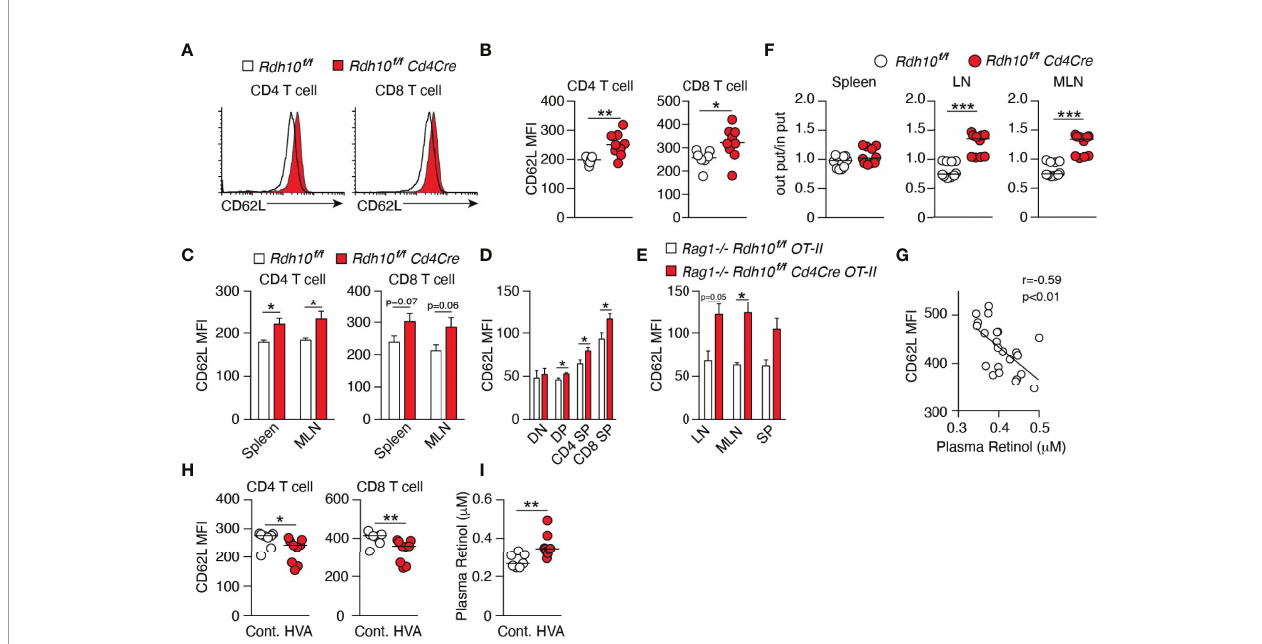
FIGURE 2 | Vitamin A metabolism mediated by Rdh10 physiologically regulates CD62L expression in T cells. (A – C) CD62L expression in CD4 + and CD8 + T cells isolated from the lymph node (LN) (A, B) , spleen, and mesenteric lymph node (MLN) (C) of 6- to 8-week-old mice. Data represent n = 7 littermate control and n = 9 Cd4Cre mice. (D) CD62L expression in CD4 - CD8 - double-negative (DN), CD4 + CD8 + double-positive (DP), CD4 single-positive (SP), and CD8 SP thymocytes of 5- week-old mice. Data represent n = 8 littermate control and n = 10 Cd4Cre mice. (E) CD62L expression in OT-II cells isolated from the LN, MLN, and spleen (SP) of 6- to 8-week-old mice. Data represent n = 2 littermate control and n = 4 Cd4Cre mice. (F) T cells puri fi ed from splenocytes of littermate control and Cd4Cre mice were labeled with either CFSE or CTV, mixed at a ratio of 1:1 and injected into B6 mice (8 × 10 6 cells per mouse). Donor cells were analyzed in the spleen, LN, and MLN 16 h later. Each symbol indicates one host mouse (n = 10). Data from two independent experiments are shown. (G – I) B6 mice were fed a high vitamin A (HVA) or control diet for 1 week. Peripheral blood was collected pre- (G) and post-feeding (H, I) , and CD62L expression levels in T cells and the plasma retinol concentration were measured. Data represent CD62L expression levels pre-feeding (n = 23) (G) and in control diet-fed (n = 8) and HVA diet-fed (n = 9) mice (H, I) . Data were analyzed by unpaired t-tests (B – F, I) , Pearson ’ s correlation coef fi cients (G) , or Mann – Whitney tests (H) . Error bars show s.e.m. *p < 0.05; **p < 0.01; ***p <